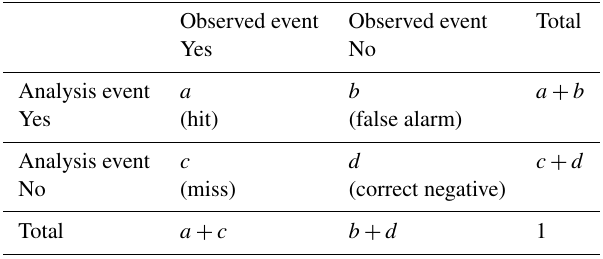
Table 1. The 2 × 2 contingency table for binary events, where a , b , c , and d correspond to the frequency of hits, false alarm, misses, and correct negatives,